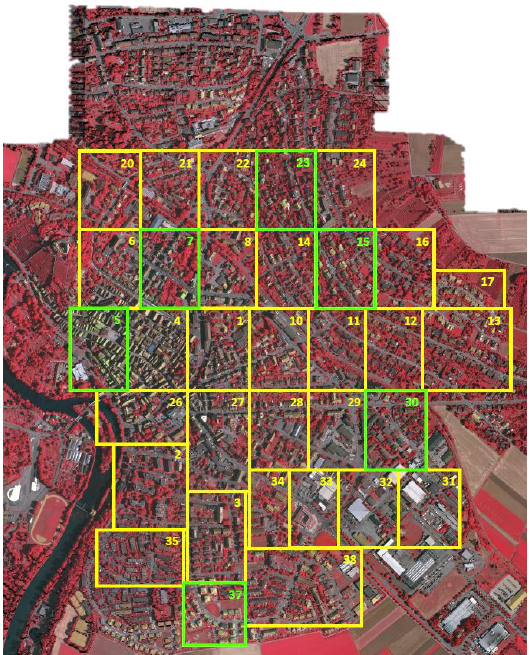
Figure 1. Overview of all 33 tiles of the Vaihingen dataset. Marked in green are the areas chosen for this work. Criteria for the choice were: ground truth available, distributed over whole area, representing different characteristics from the whole dataset (ratio of